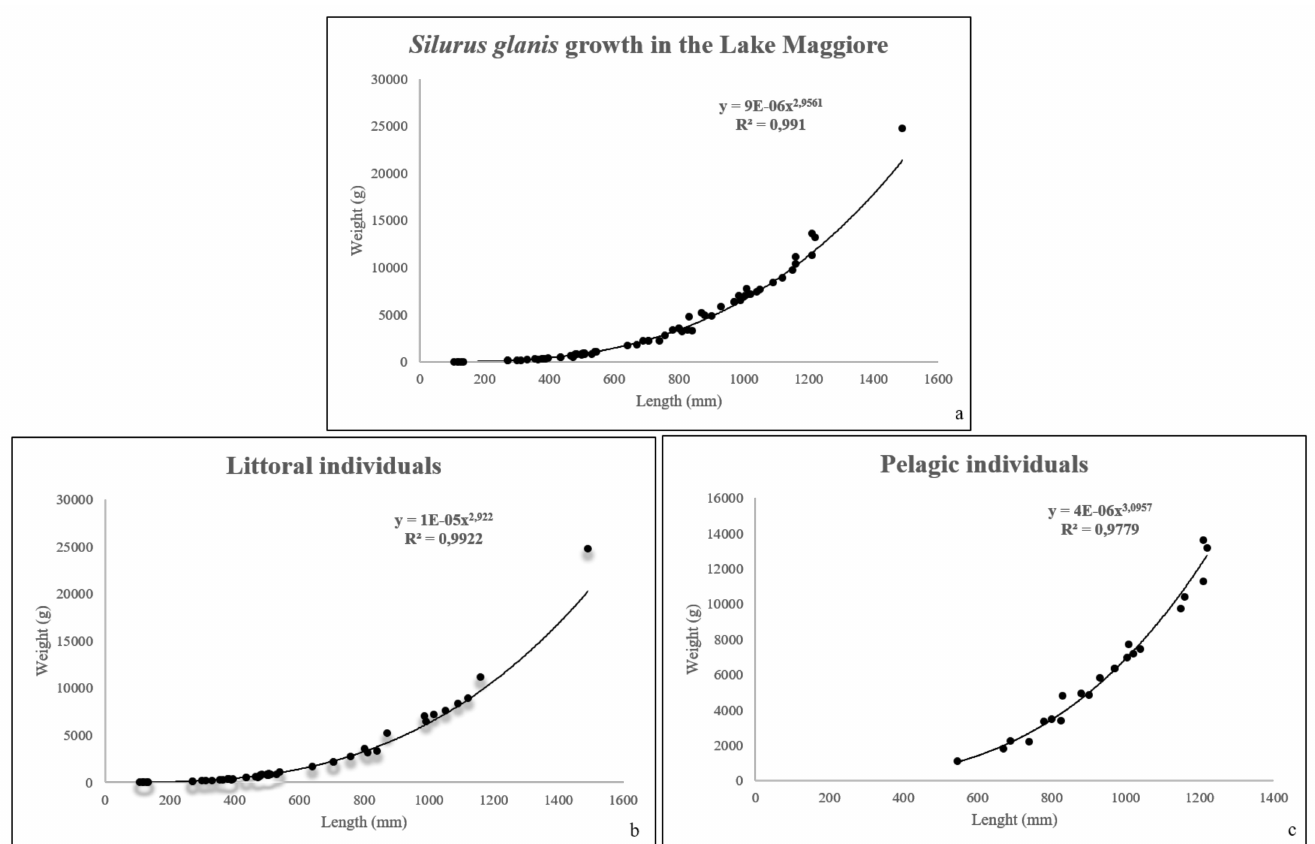
Figure 2. Growing rate of ( a ) Silurus glanis in the Lake Maggiore based on weight and length of all individuals. ( b ) only for individuals caught in the littoral habitat. and ( c ) only in the pelagic